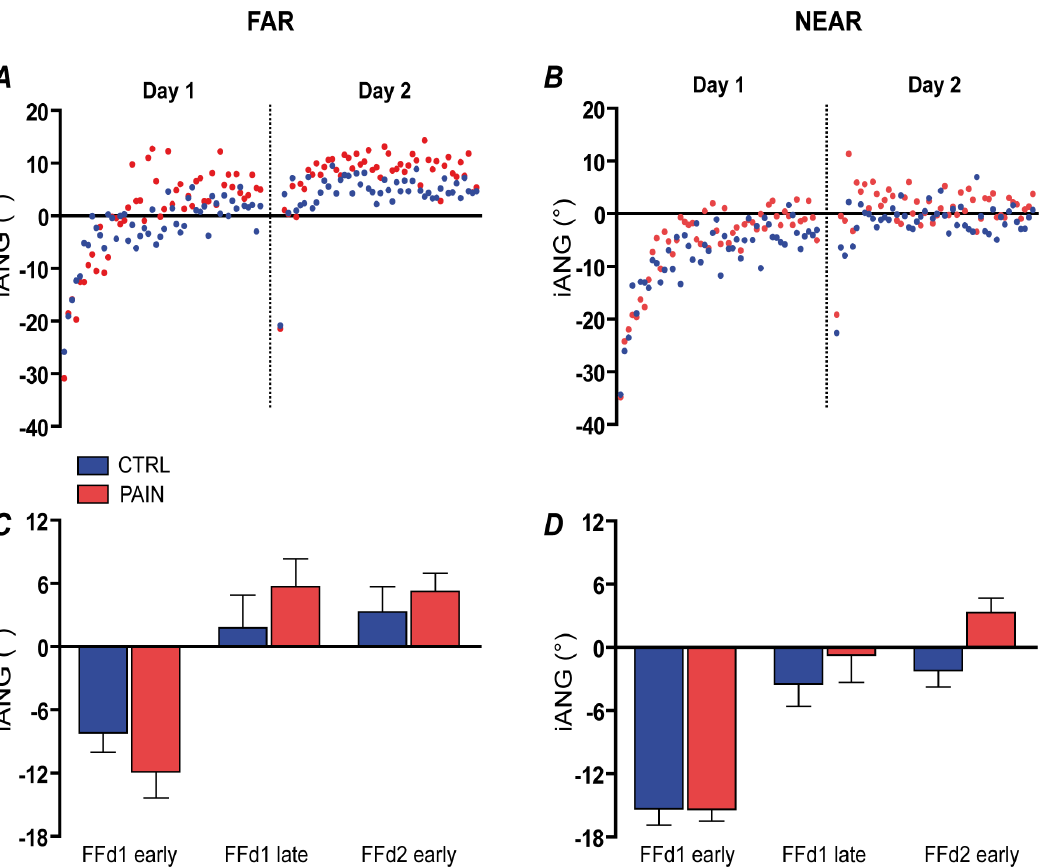
Figure 4. Changes in initial angle of deviation (iANG) across time for each group. Panel A shows the time course for the FAR target, and Panel B for the NEAR target. Panels C and D shows the average iANG for each group on sections of the time course selected for statistical analyses (Early/Late Day 1 and Late Day 2), respectively for FAR and NEAR target. On Day 1, both groups exhibited a reversal of the direction of their iANG: early in the force field their hand was deflected in the direction of the force field (negative angle value). Progressively, the movement was initiated in the opposite direction in anticipation of the perturbation. At the beginning of Day 2 iANG direction was opposite to the deviation produced by the force field and similar to what was seen at the end of Day 1, demonstrating the retention of the feedforward strategy acquired on Day 1. Error bars show the standard error of mean (SEM).